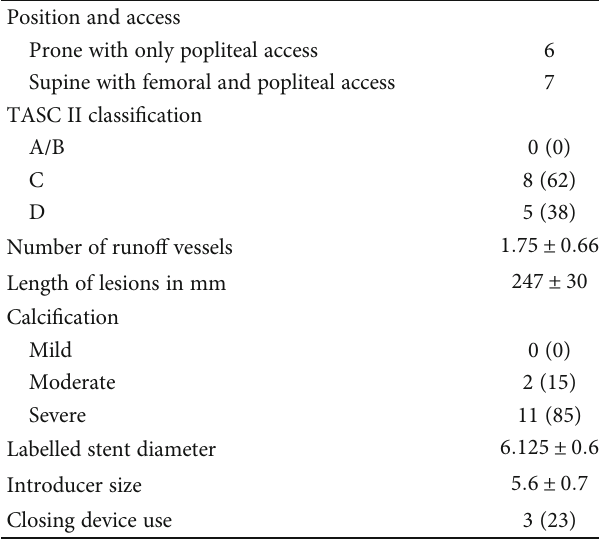
Table 3: Lesion and procedure